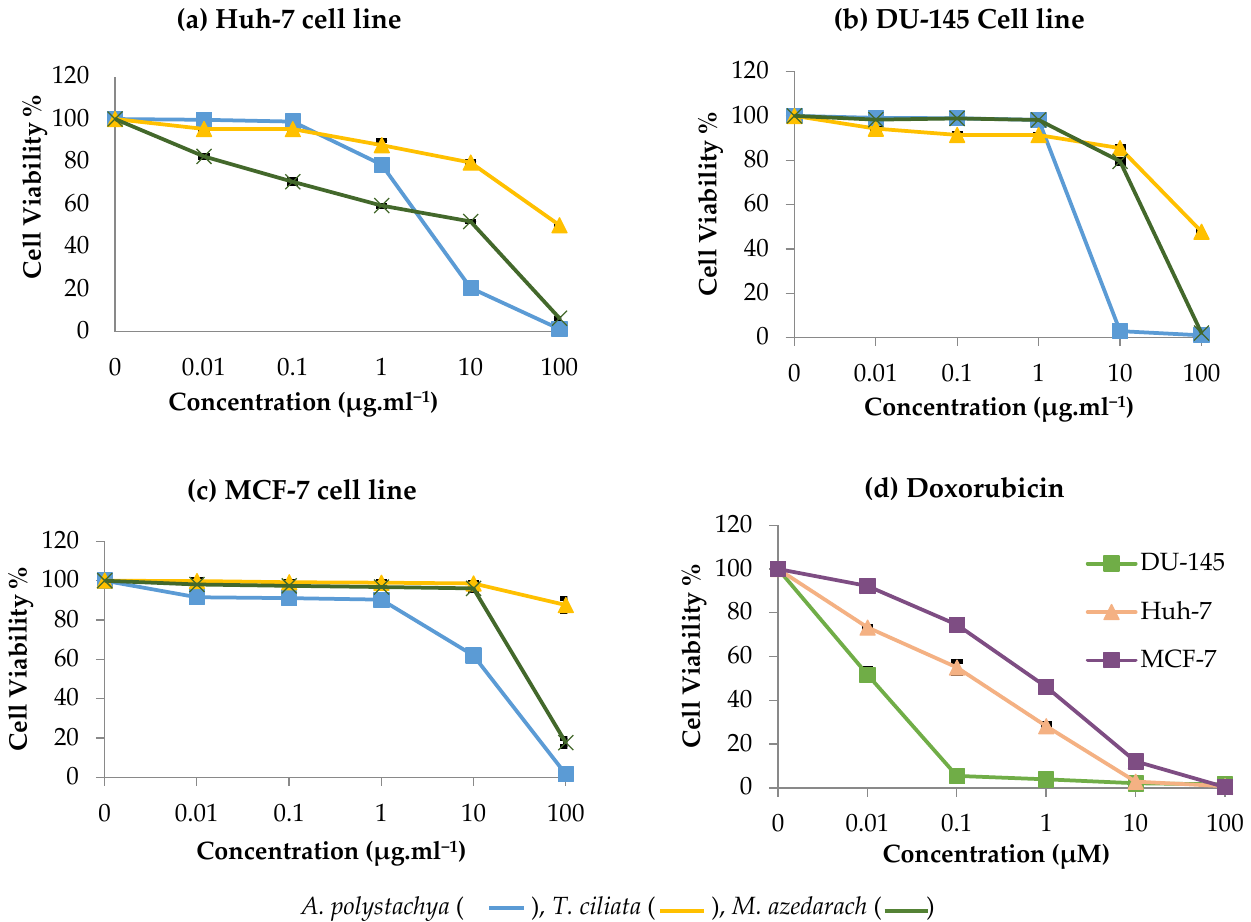
Figure 2. In vitro cytotoxic activity of A. polystachya , T. ciliata and M. azedarach extracts, using Sulforhodamine B Assay (SRB assay) against 3 cancer cell lines: ( a ) Huh-7 (human hepatocellular carcinoma cell), ( b ) DU-145 (human prostate carcinoma cell) and ( c ) MCF-7 (human breast adenocarcinoma cell). ( d ) In vitro cytotoxic activity of Doxorubicin used as drug reference. Data are represented as mean ± SD ( n = 3).